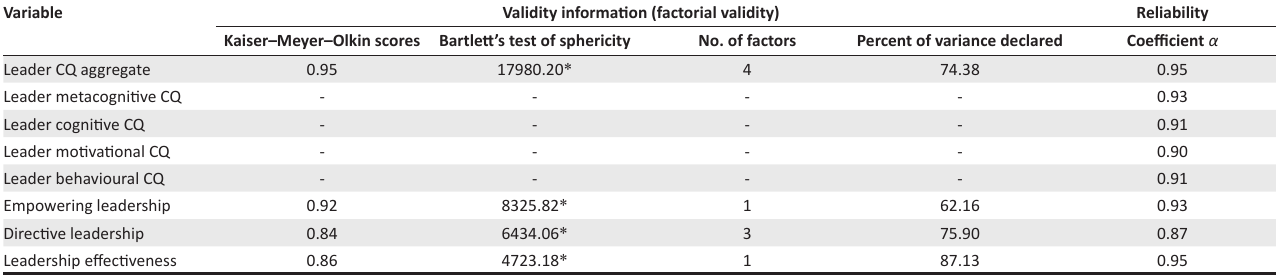
TABLE 5: Factor analysis and reliability information.